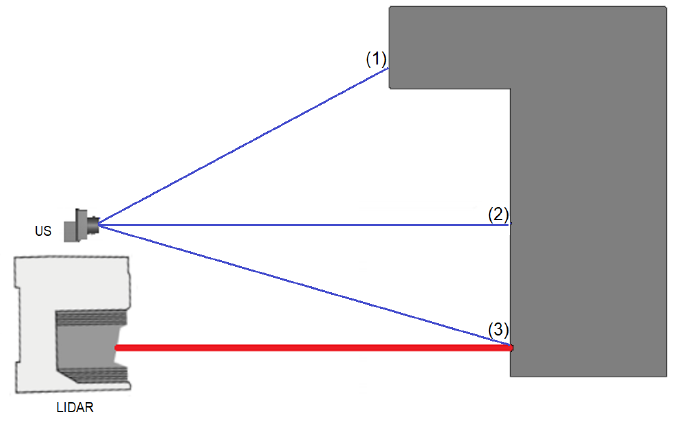
Figure 12. Sensor measurement in different scenarios.